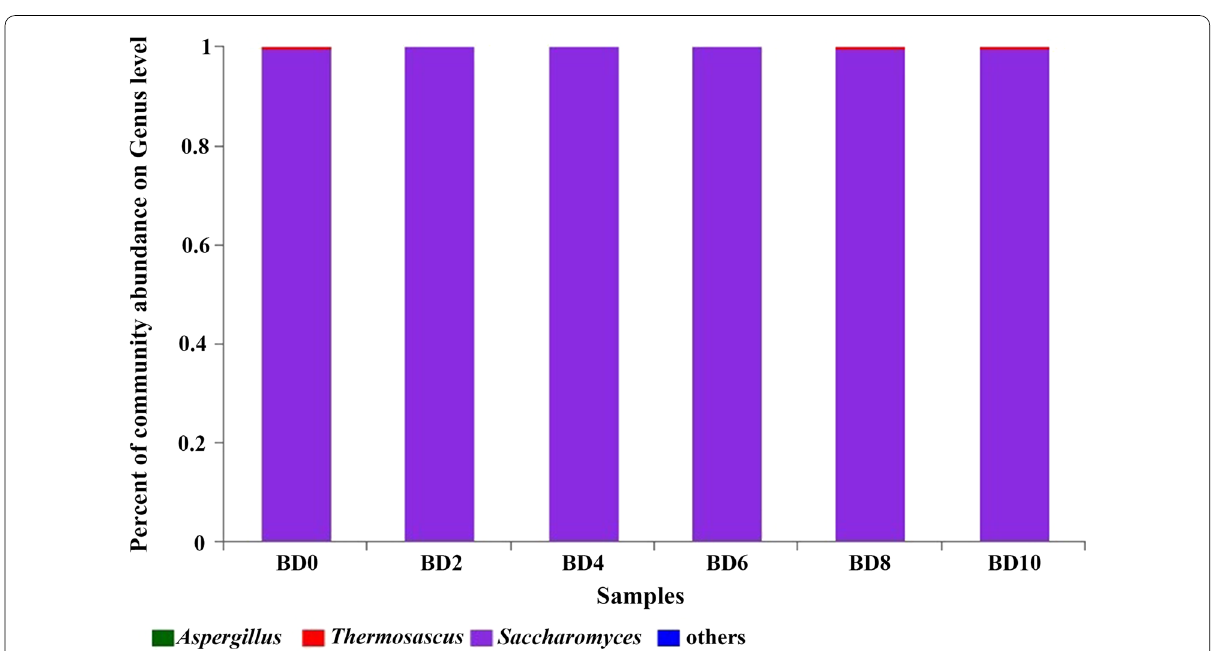
Fig. 2 Fungal diversity during the fermentation process in northern Huangjiu at genus level. BD means “Beizong Huangjiu fermentation